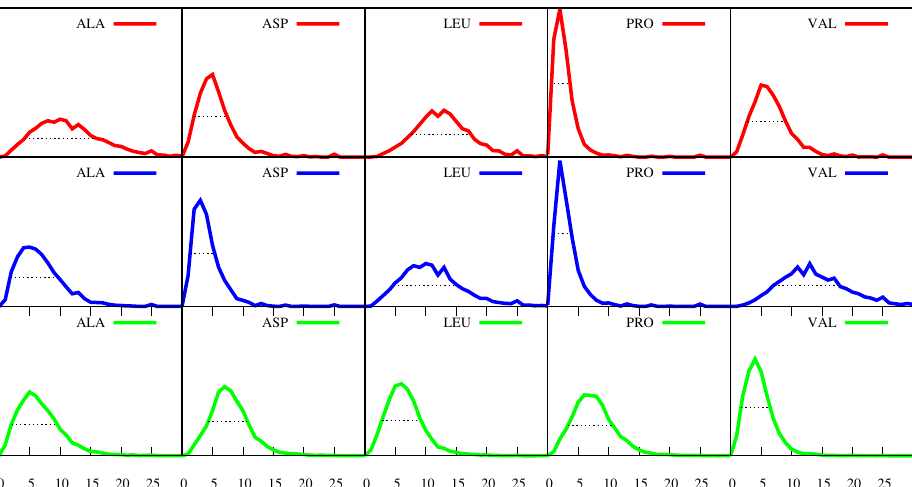
Figure 2. Distributions/histograms for a few of the frequencies f ( a , s , p ) , where the amino acid a is specified at the top of each plot and where red is for s = α -helix, blue is for s = β -sheets and green is for s = loops. In this figure, the variable f ( a , s , p ) (the x-coordinate) runs from zero (which means that none of the amino acids a are found in s ) to 30 (which means that 30% of the amino acids in the protein are a ’s found in s ). The y-coordinate is proportional to the number of proteins with a given value of f ( a , s , p ) . The scale of the y-coordinate is the same for all plots and all distributions are normalised. The horizontal dotted lines are the FWHM of the distributions (see